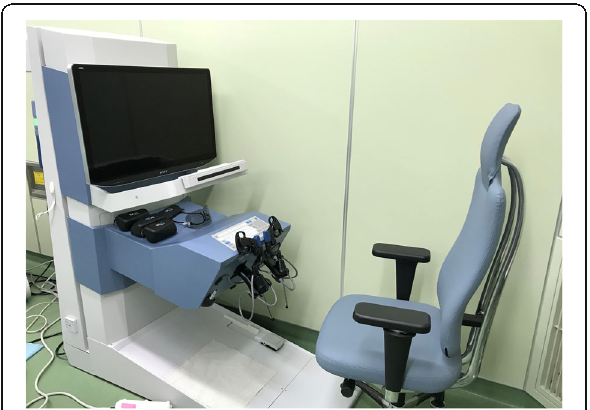
Fig. 4 A system of the remote control unit called a cockpit Fig. 5 Ideal port placement we